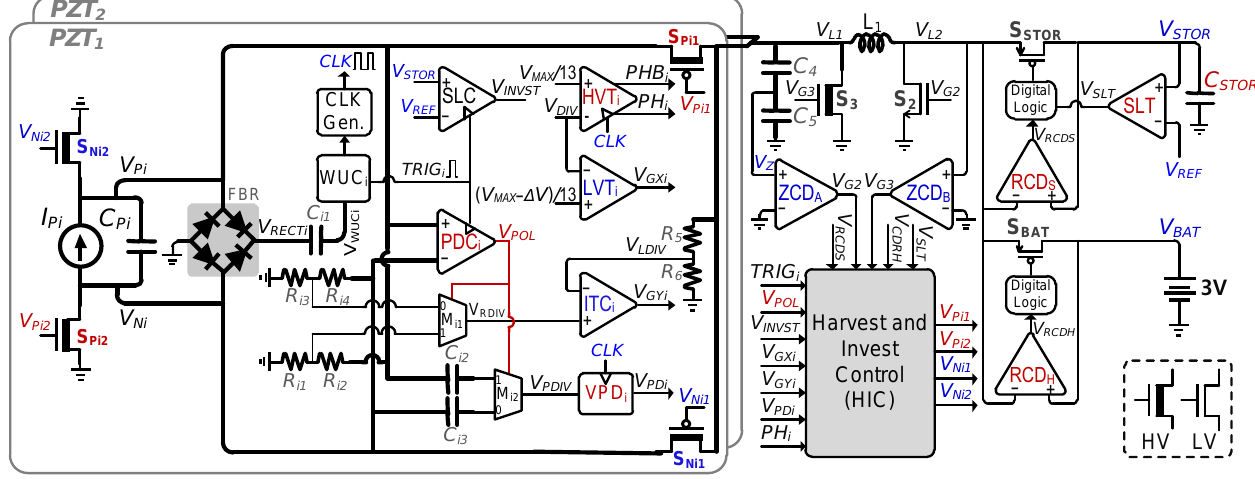
Figure 6. Top-level circuit of Dual-PZT energy-harvesting interface for energy investment and harvesting with time-shared inductor.